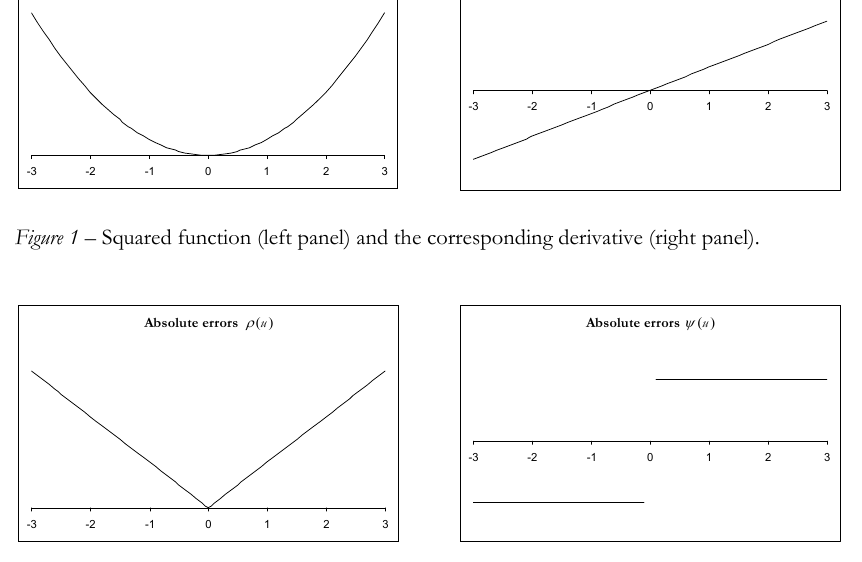
Figure 2 – Absolute function (left panel) and the corresponding derivative (right